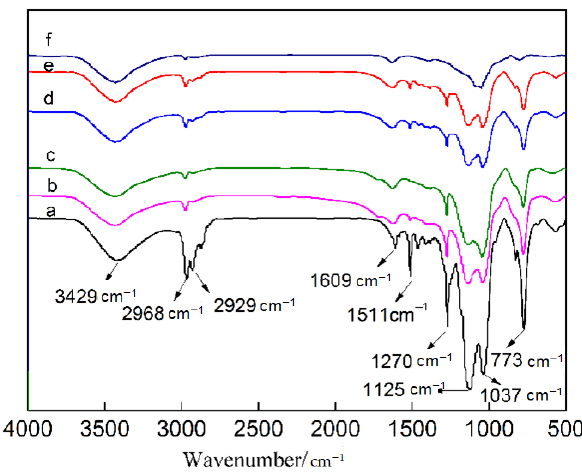
Figure 8. IR spectra analysis of the material treated at different heat treatment temperatures. ( a ) 50 °C; ( a ) 50 ◦ C; ( b ) 100 ◦ C; ( c ) 150 ◦ C; ( d ) 200 ◦ C; ( e ) 250 ◦ C; ( f ) 300 ◦ C. ( b ) 100 °C; ( c ) 150 °C; ( d ) 200 °C; ( e ) 250 °C; ( f ) 300 °C.